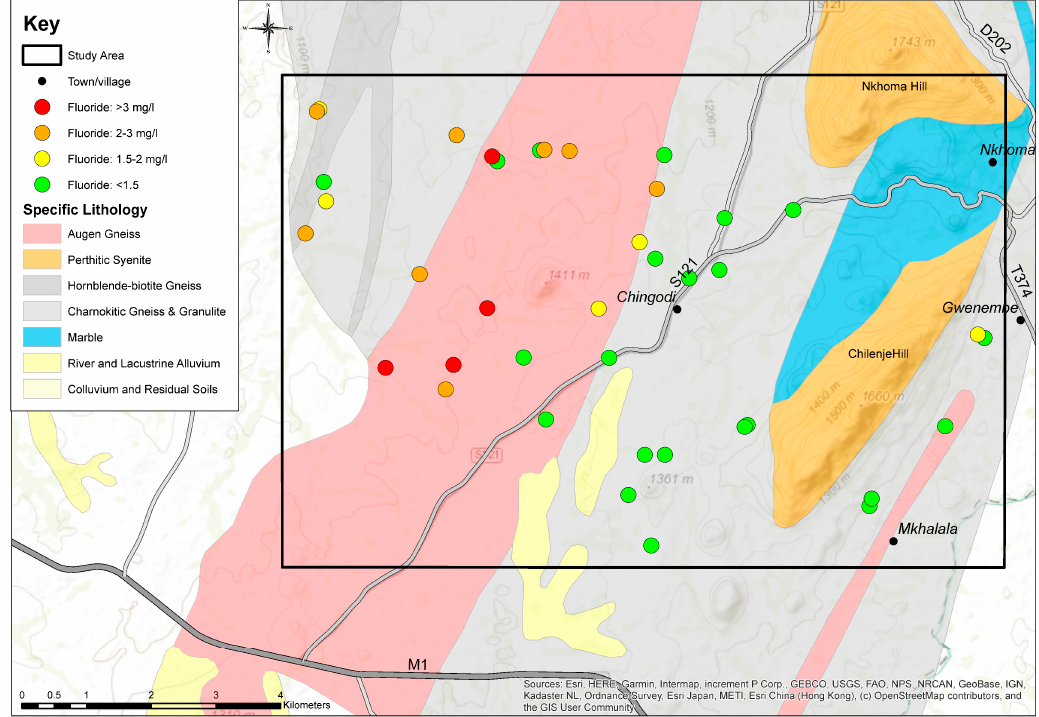
Figure 7. Map showing fluoride data in the study area plotted onto local